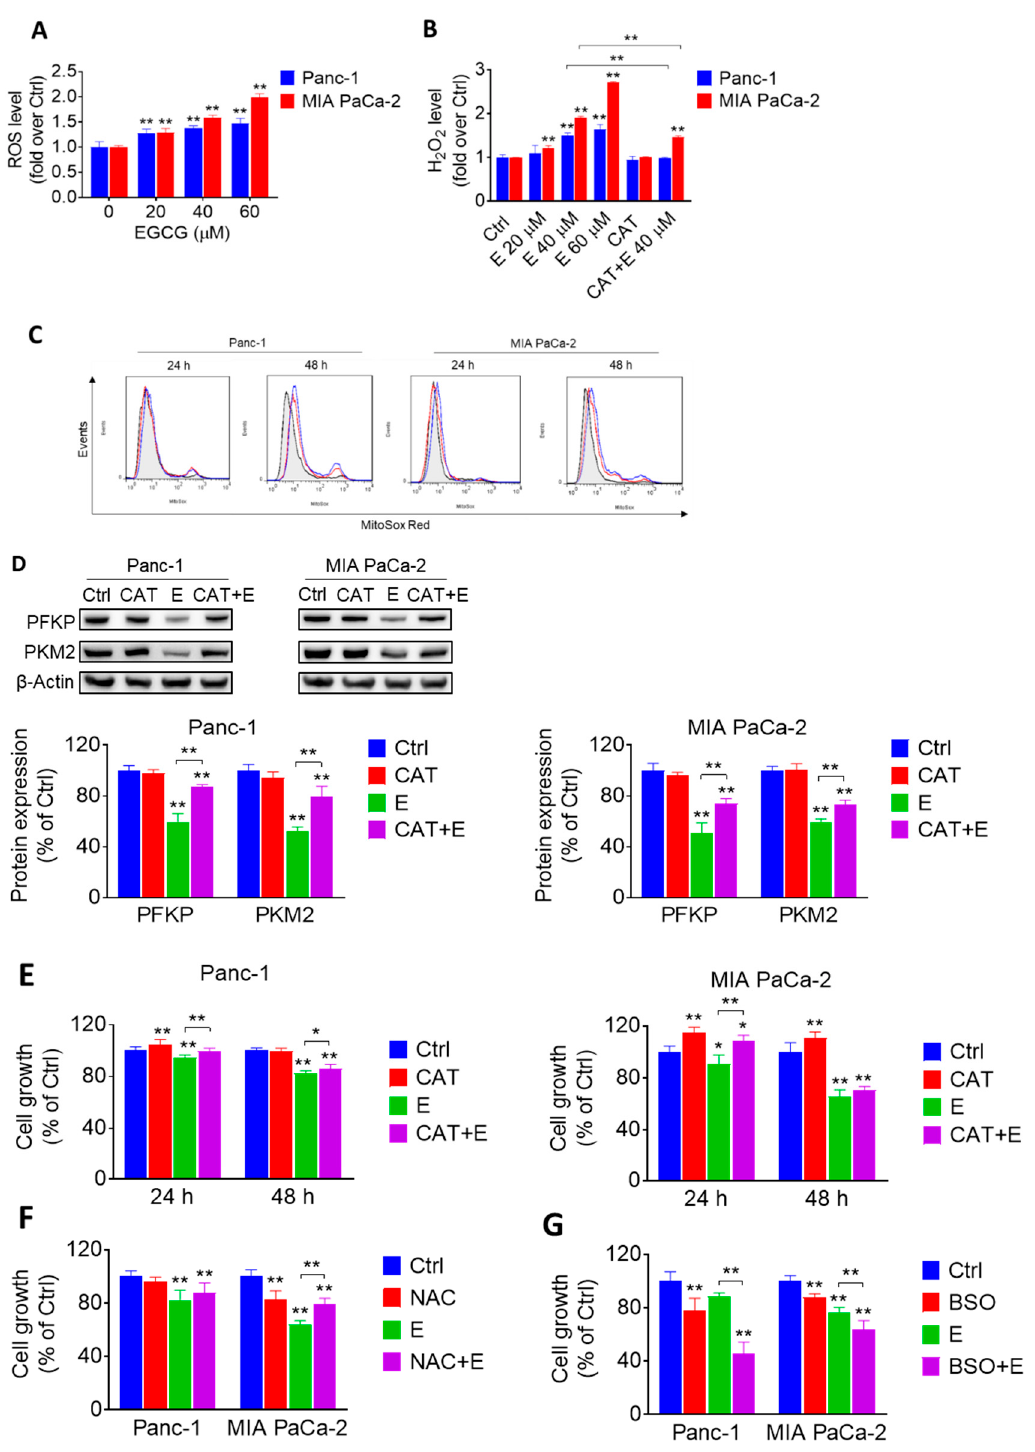
Figure 3. EGCG affects the glycolytic pathway in pancreatic cancer through a reactive oxygen species (ROS)-dependent manner. ( A ) 2 ′ ,7 ′ -Dichlorodihydrofluorescein diacetate (H2DCFDA) fluorescence was measured in Panc-1 and MIA PaCa-2 cells treated without (control) or with EGCG at various concentration for 24 h. Results are expressed as fold change of control. * p < 0.05, ** p < 0.01 vs. control. ( B ) Amplex TM Red was used to evaluate the levels of hydrogen peroxide level released by Panc-1 and MIA PaCa-2 cells. Results are expressed as fold change of control. * p < 0.05, ** p < 0.01 vs. control. ( C ) EGCG induces a concentration- and time-dependent increase in mitochondrial superoxide anion levels. The levels of superoxide anion in the mitochondria were determined by flow cytometry using the MitoSOX-Red fluorescent probe. Black, red and blue lines represent control,